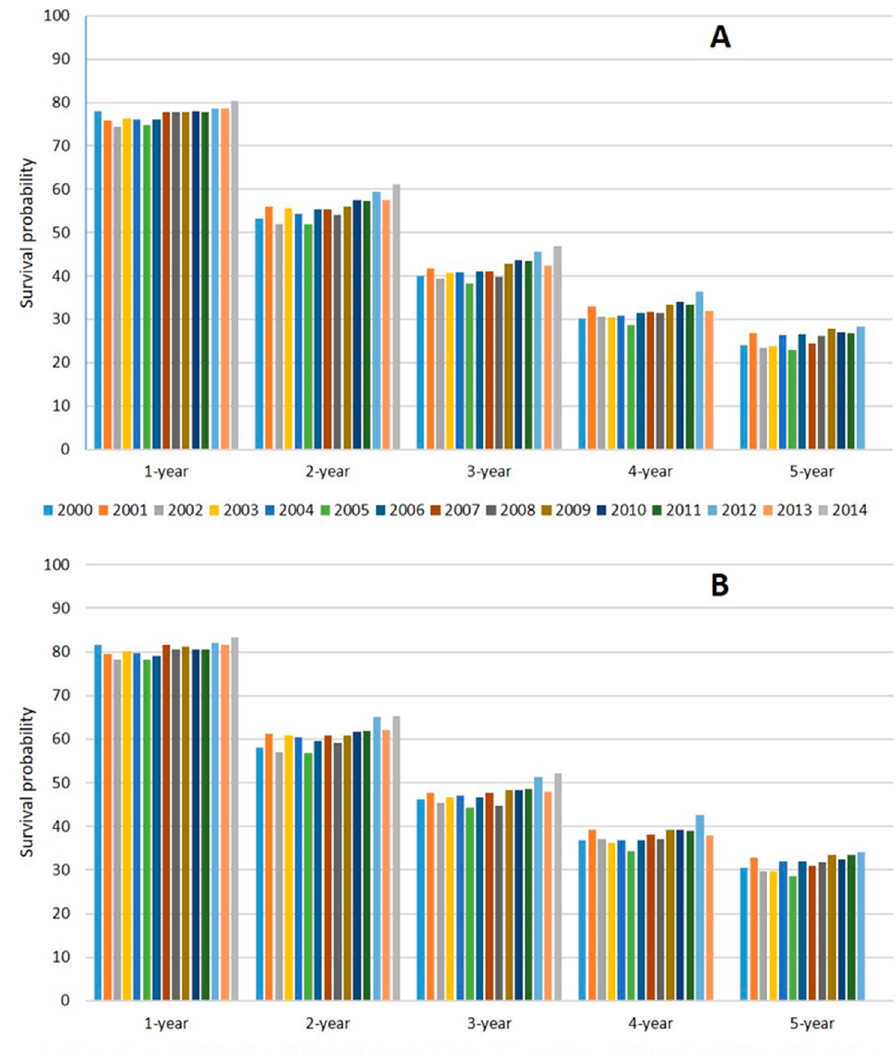
Figure 3. Age-standardized 1- to 5-year OS ( A ) and CSS ( B ) of patients according to year of diagnosis.